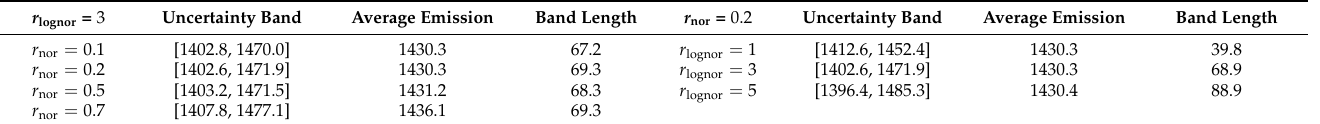
Table 4. Uncertainty of total emission under different combinations of 𝑟 (cid:2922)(cid:2925)(cid:2917)(cid:2924)(cid:2925)(cid:2928) and 𝑟 (cid:2924)(cid:2925)(cid:2928) in 2018. Unit of methane emission is kt.